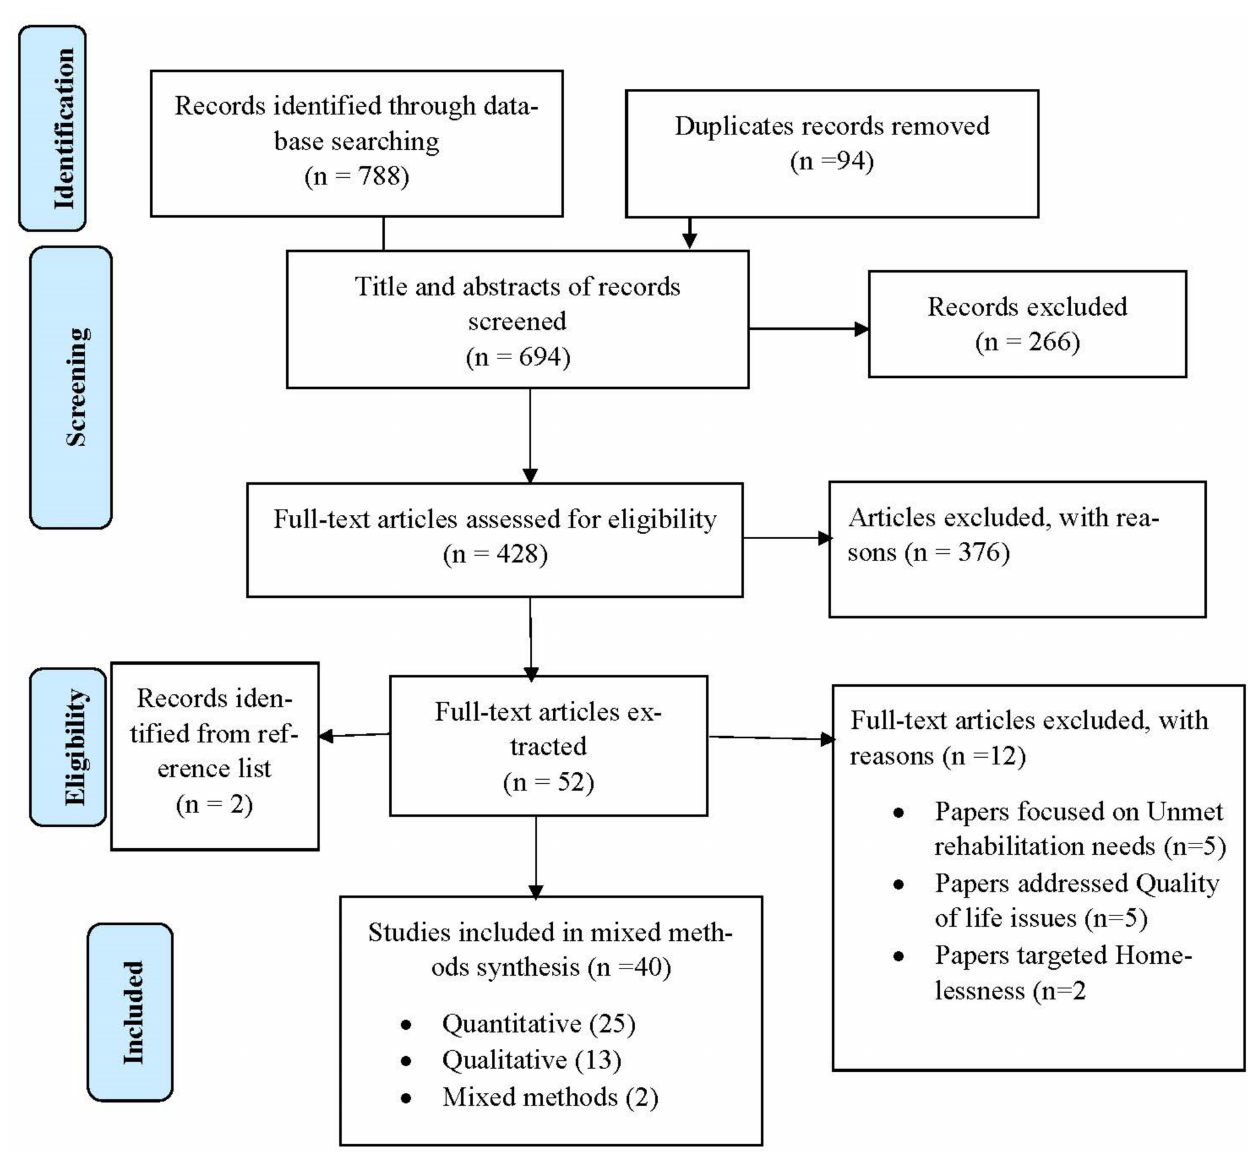
Figure 1. Flow chart of included